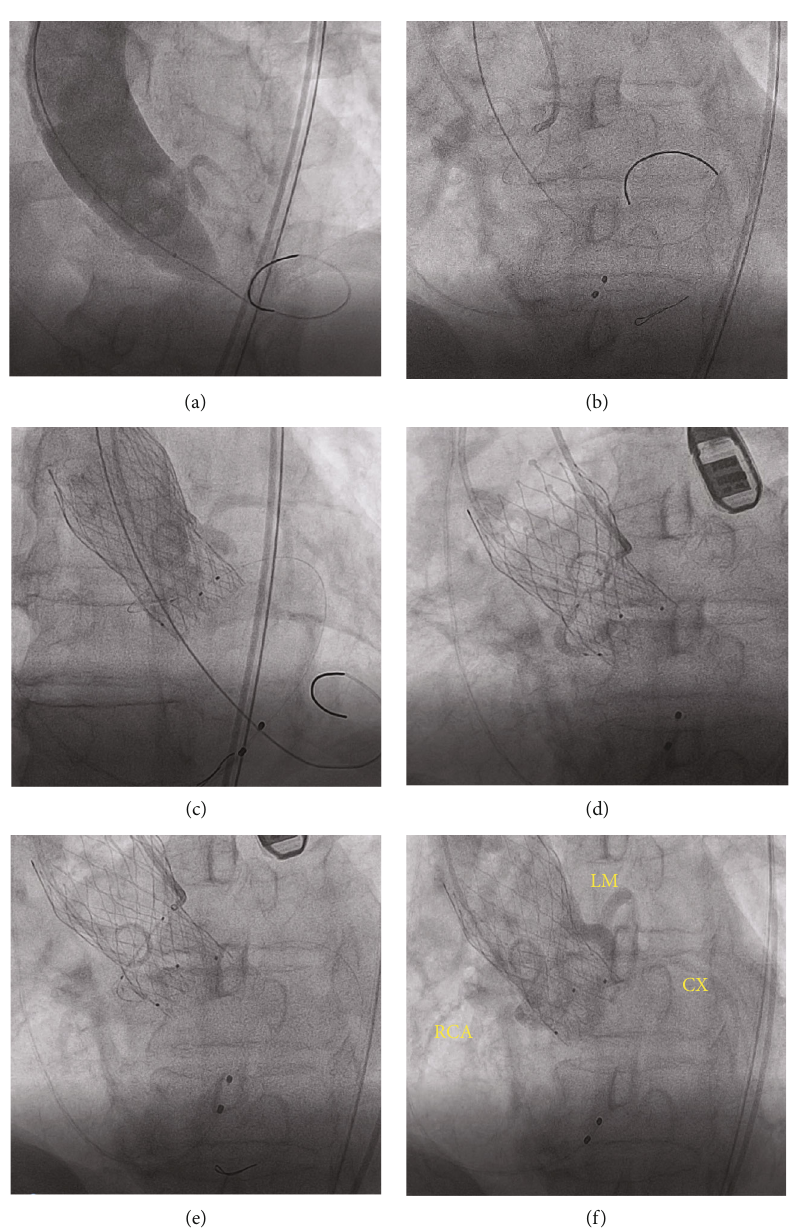
Figure 2: Balloon aortic valvuloplasty and simultaneous aortic root injection showing decreased coronary fl ow to TIMI-0 in the RCA and CX. One guidewire was advanced to the RCA and CX with a 2 : 0 ∗ 20 mm semicompliant balloon. There was fl ow compromise in the right coronary system and CX to TIMI-0 fl ow after TAVR, followed by deployment of two stents from the proximal CX branch to the sinotubular junction. The fl ow of the right coronary artery and CX was retained, and the elevated ST segment in the EKG was